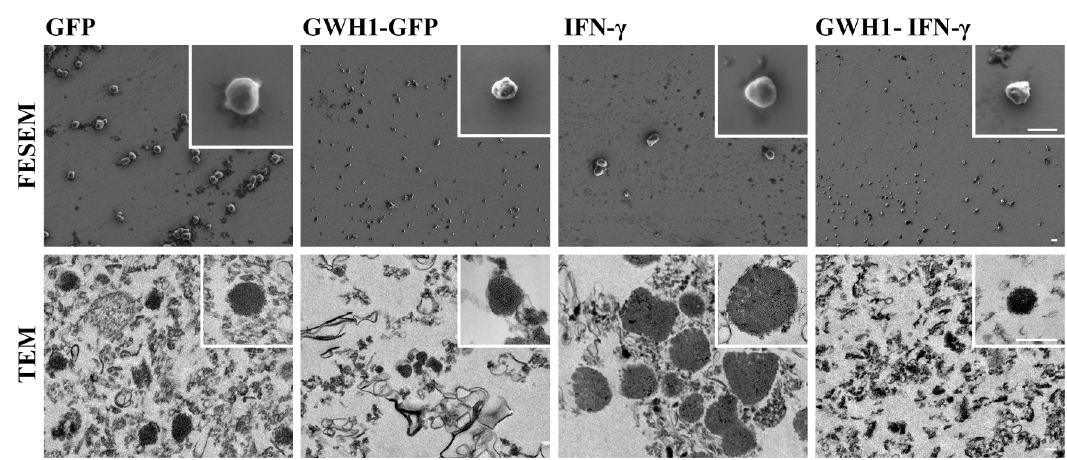
8 of 16 Figure 4. Growth kinetics of E. coli in the mouse mammary gland at 6, 12 and 24 h after the administration of 100 CFU through the teat channel. The bacterial loads for each time point were evaluated in 8 individual mammary glands (4 mice).Bars represent the mean ± standard deviation. 3.6. Characterization of IBs Recombinant protein production in bacteria induces the formation of discrete protein clusters usually located at the cellular poles. These supramolecular complexes, known as IBs, contain functional recombinant protein. Released recombinant proteins tend to co-purify with other cellular proteins using IBs purification methods. In any case, in this study, a representative amount of the produced recombinant protein was observed in all cases (Figure 1(B2)). IFN- γ IBs showed the best releasing efficiency, being the amount of protein observed qualitatively different from the other candidates (Figure 1C). On the other hand, just a faint band was observed for GFP-based proteins, indicating a poor releasing process (Figure 1C). The size distribution of the solubilized protein was also evaluated (Figure 1E). Although soluble aggregates were mainly released from all protein designs, only GWH1-GFP included a monomeric distribution, which indicated the presence of two